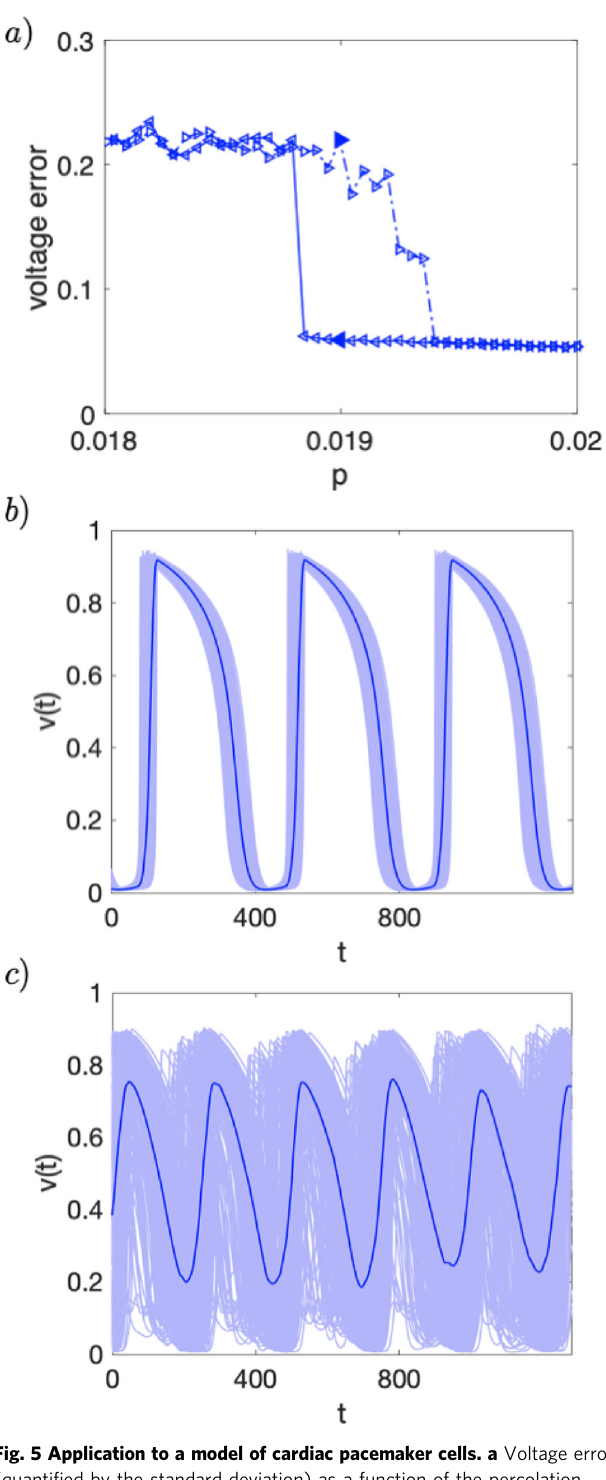
Fig. 5 Application to a model of cardiac pacemaker cells. a Voltage error (quanti fi ed by the standard deviation) as a function of the percolation parameter p , under forward and backward percolation dynamics plotted in dot-dashed and solid lines, respectively. b , c Individual voltage time series v i ( t ) and the mean, plotted in light and dark blue stokes, respectively, from right before and after the backward explosive